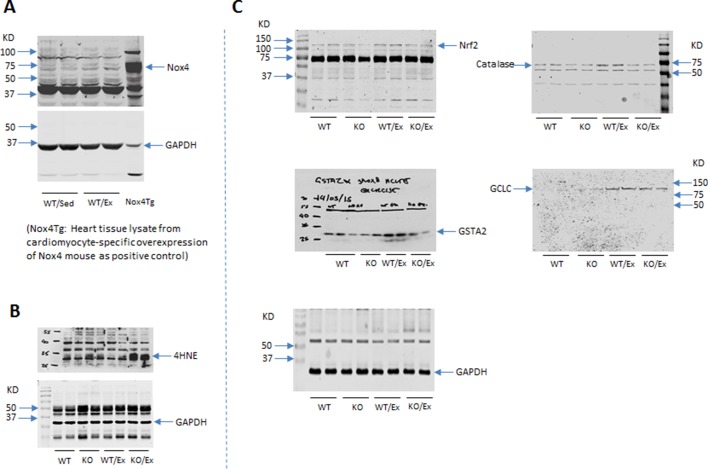
Full images of Western blots in Figure 1.